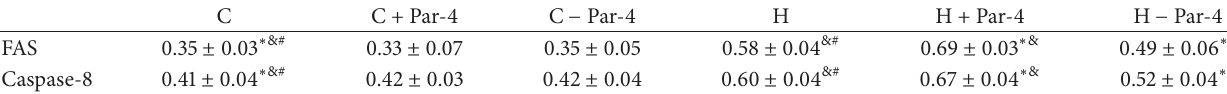
Table 4: The protein expression of FAS and caspase-8 of each group.